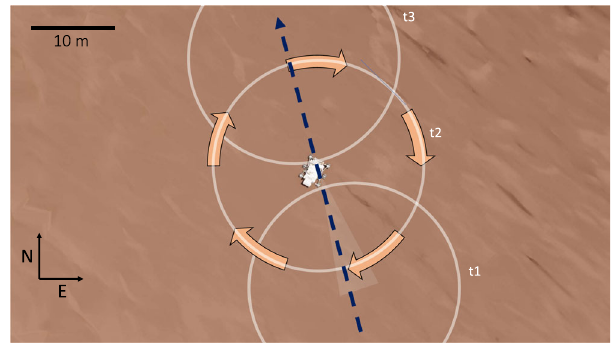
Fig. 4 | Dust devil trajectory. The dust devil trajectory direction (blue dashed arrow) and size (white circles) with respectto the Perseveranceroverand the local terrain at the time of the encounter. The dust devil has a trajectory coming from Azimuth(Az)=164°,andthevortexdiameterisestimatedfromcombineddataand modeling to be 25m. The rover Navigation camera (Navcam) fi eld of view is indi- cated by the pale triangle. At t 1 Perseverance is in the leading vortex wall, at t 2 Perseverance is inside the eye of the vortex, and at t 3 Perseverance is in the tailing vortexwall.Thevortexandtheroveraredrawntoscale.Theorangearrowsindicate the clockwise rotational direction of the vortex